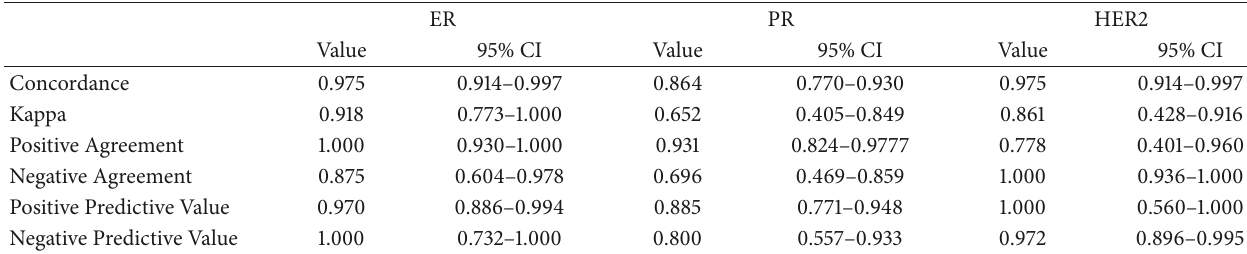
Table 3: Concordance rates and agreement measures of microarray gene expression compared to Immunohistochemistry as reference.